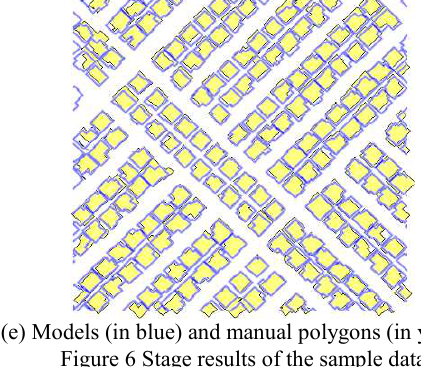
Figure 6 Stage results of the sample data